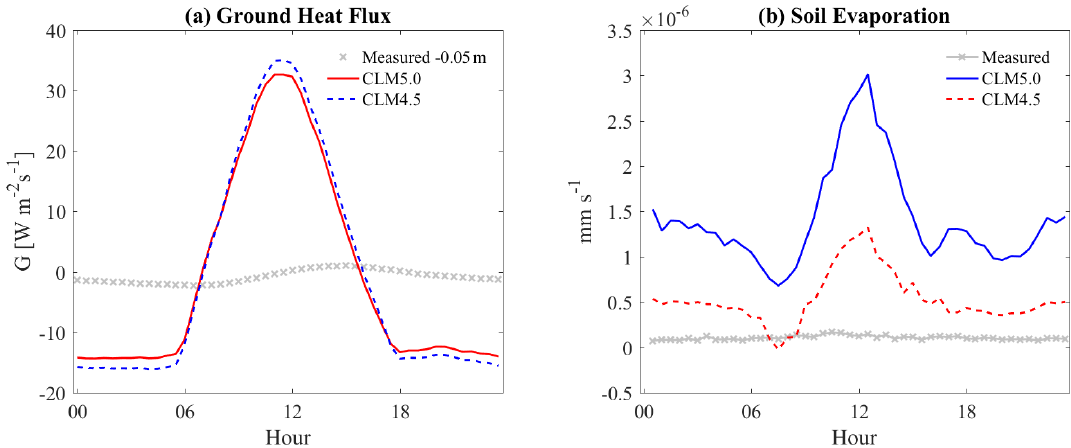
Figure 10. The ensemble diurnal variation of soil–ground heat fluxes (into soil + ) (a) and soil